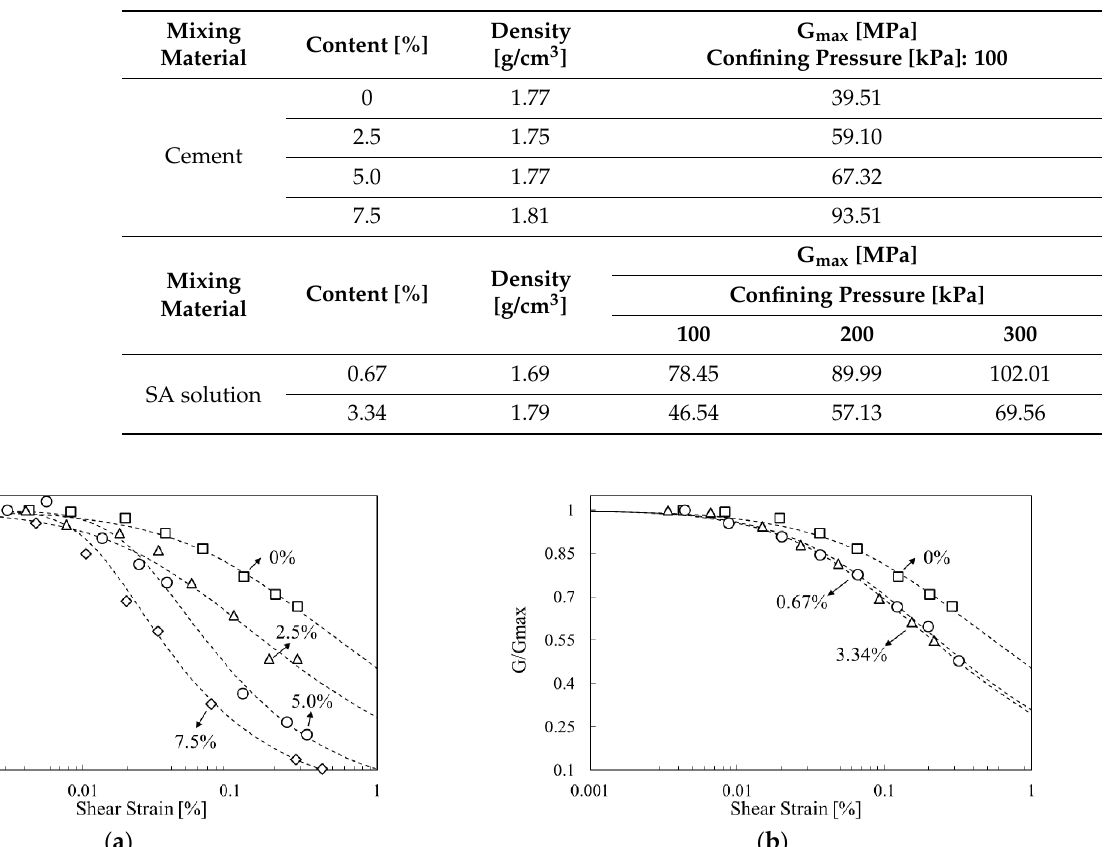
Table 4. Shear modulus of reinforced soil in resonant-column test. G max : maximum shear modulus.